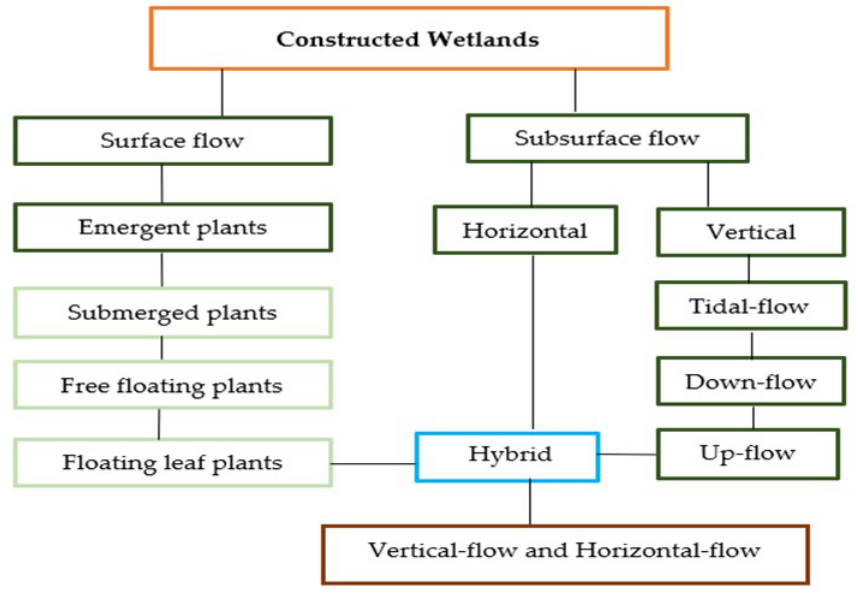
Figure 7. Classification of constructed wetlands for wastewater treatment, sourced from References